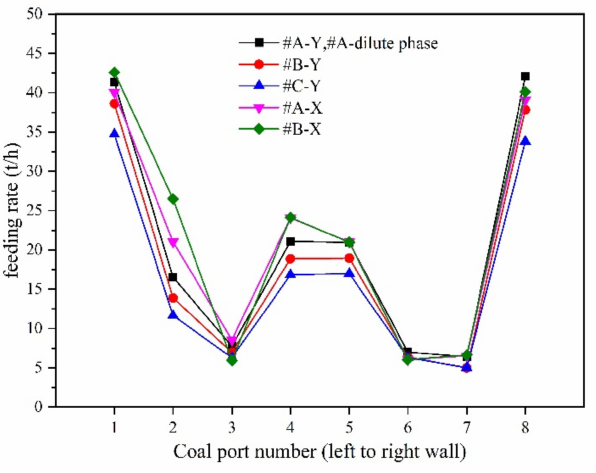
Figure 8. Fuel distributions during the measurement of at different